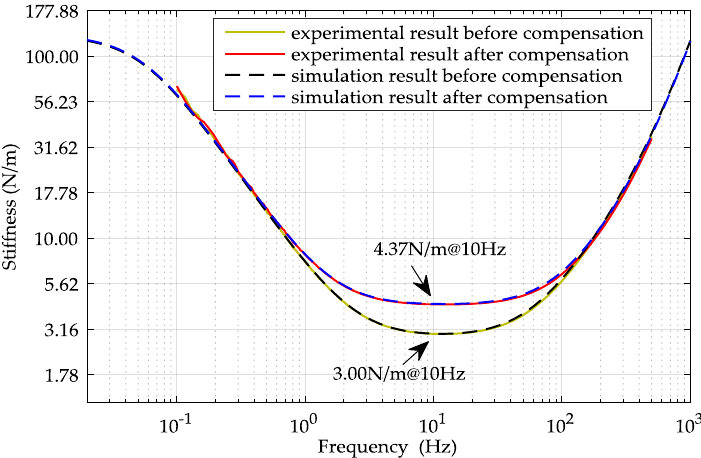
Figure 9. Simulated and experimental results of the x -axis suspension stiffness.